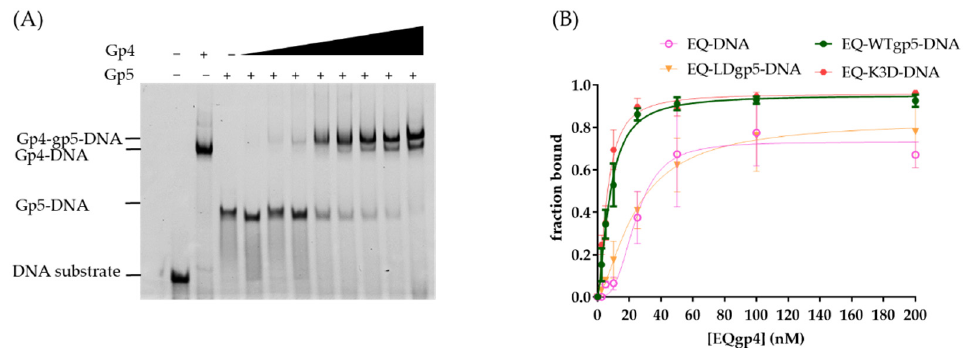
Figure 4. Cooperative gp4-gp5 binding to the fork template. ( A ) A representative gel of mobility shift assay for gp4-gp5 binding. ( B ). Quantification of the supershift gp4 binding to DNA or gp5-DNA. Legends suggested the type of gp4 and gp5 variants used in the binding assay. Table 2. K d of the DNA-gp5 variants complexed with EQgp4 and EQgp4 Δ C.